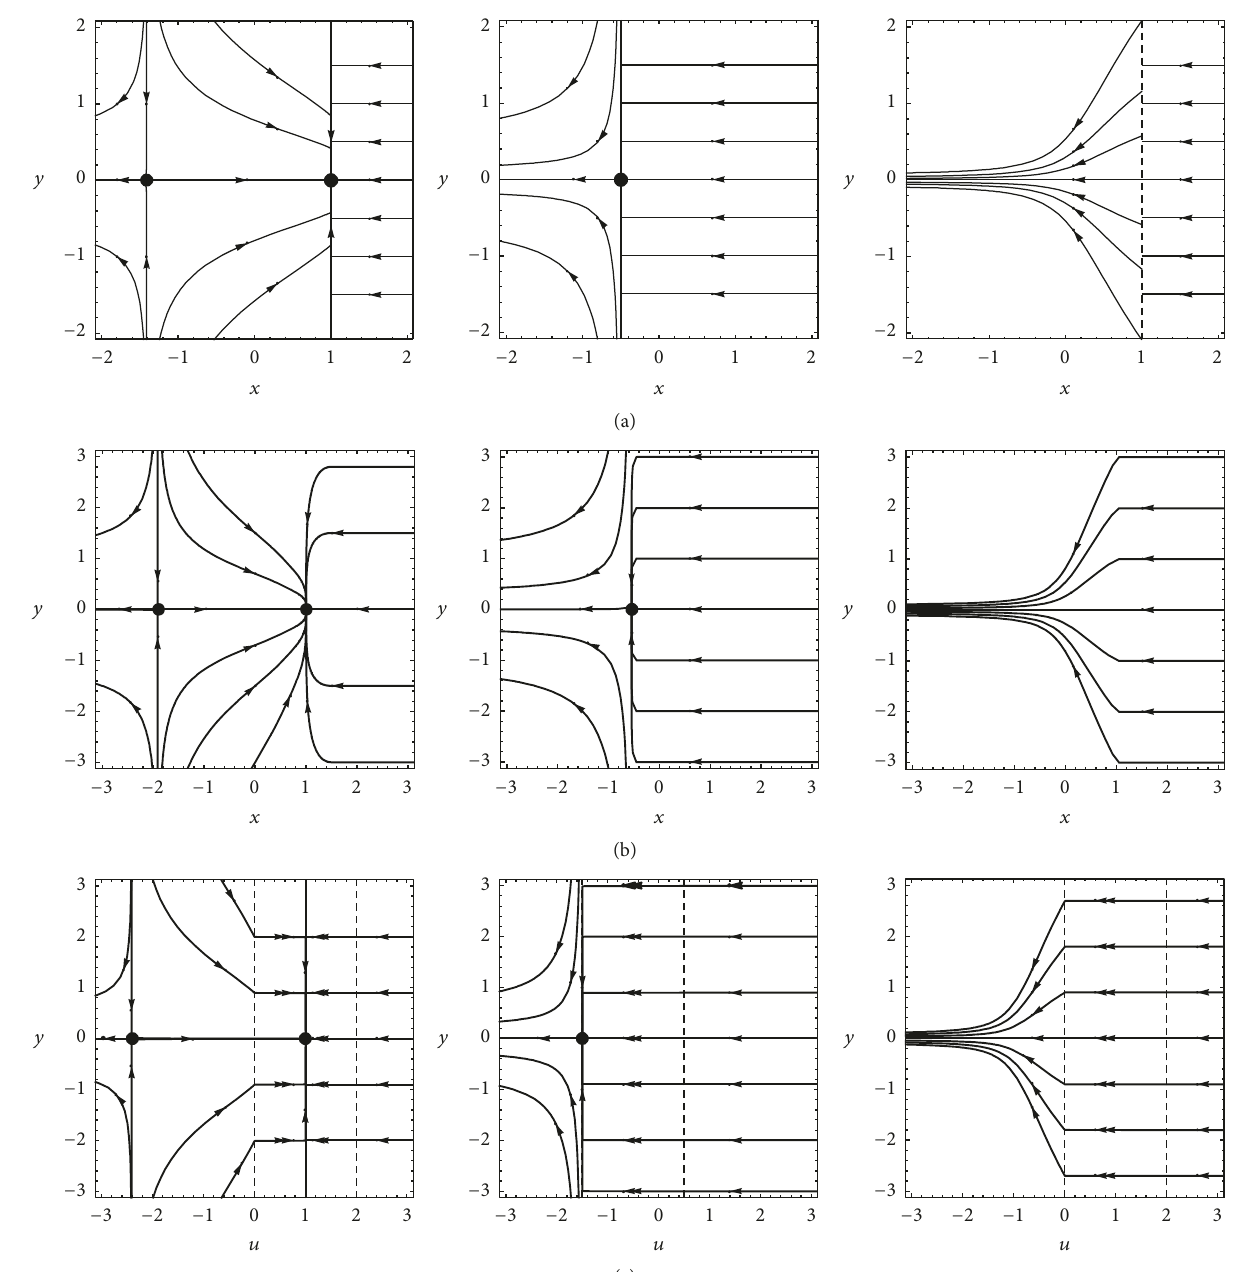
Figure5:(a)Nonsmoothfoldbifurcationinthecaseofboundarynode.(b)Thecorrespondingregularization.(c)Thecorrespondingslow-fast